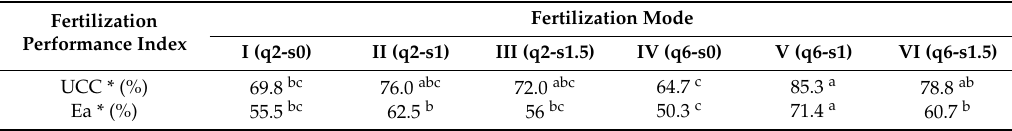
Table 6. The evaluation of the fertilization performance.